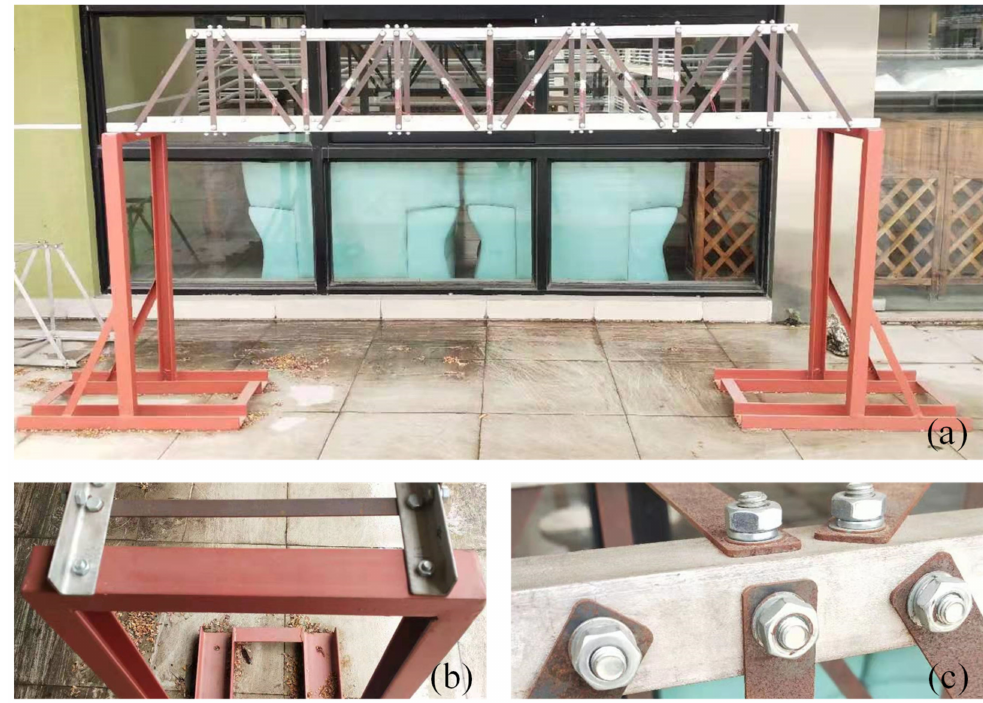
Figure 3. The bridge model with 60 flat steel bars. ( a ) Model layout; ( b ) boundary condition; ( c ) connection type.